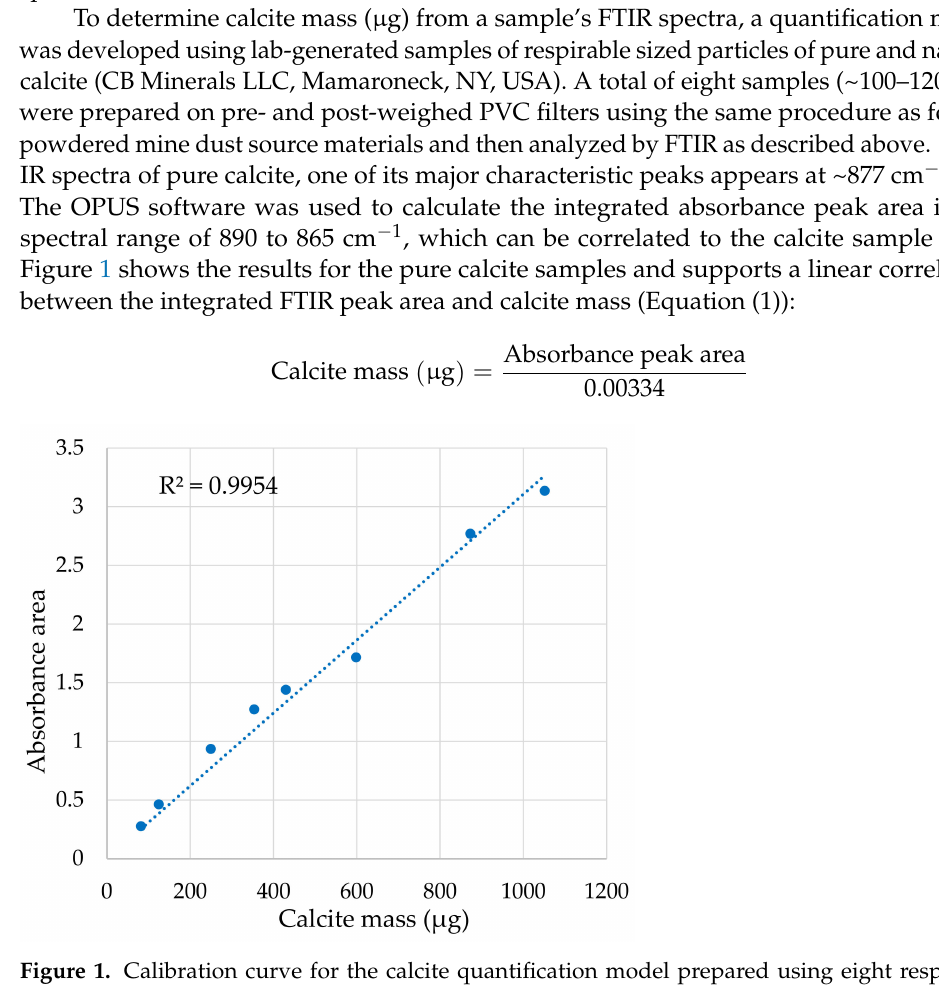
Figure 1. Calibration curve for the calcite quantification model prepared using eight respirable samples of respirable pure calcite. The Y-axis shows the integrated absorbance peak area for calcite (between 890 to 865 cm − 1 ) as a function of sample mass ( µ g) determined